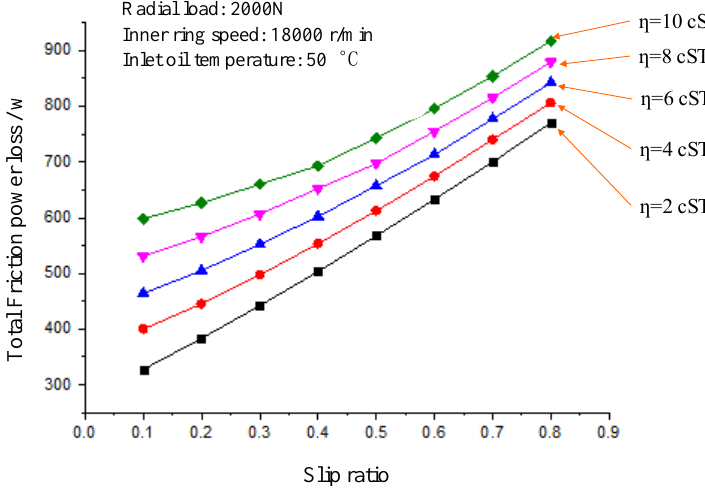
Figure 6. Effect of the lubricant kinematic viscosity on the total friction power loss of the bearing.